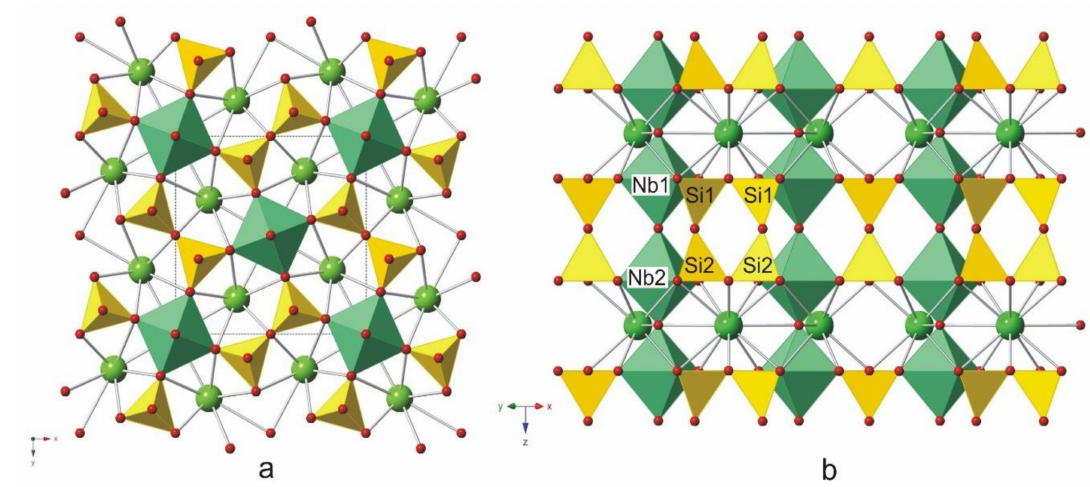
Figure 14. The crystal structure of rippite in (001) ( a ) and (110) ( b ) projections. Large green balls—K; small red